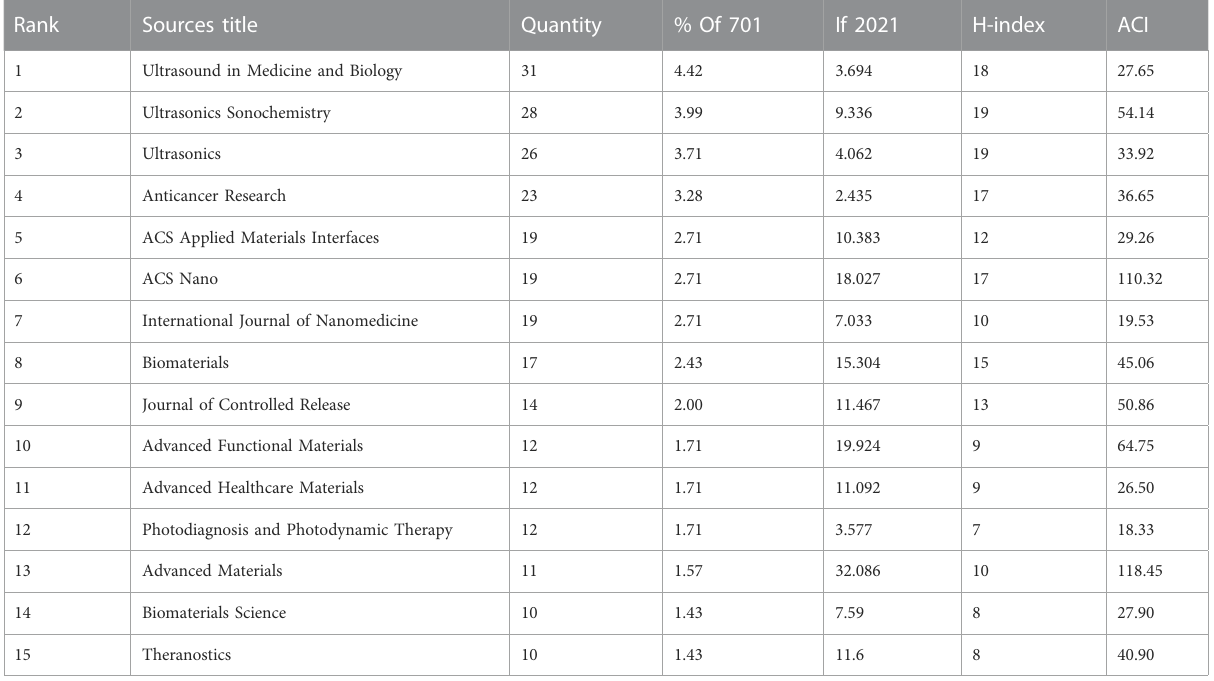
TABLE 2 The top 15 most active journals in research scope of